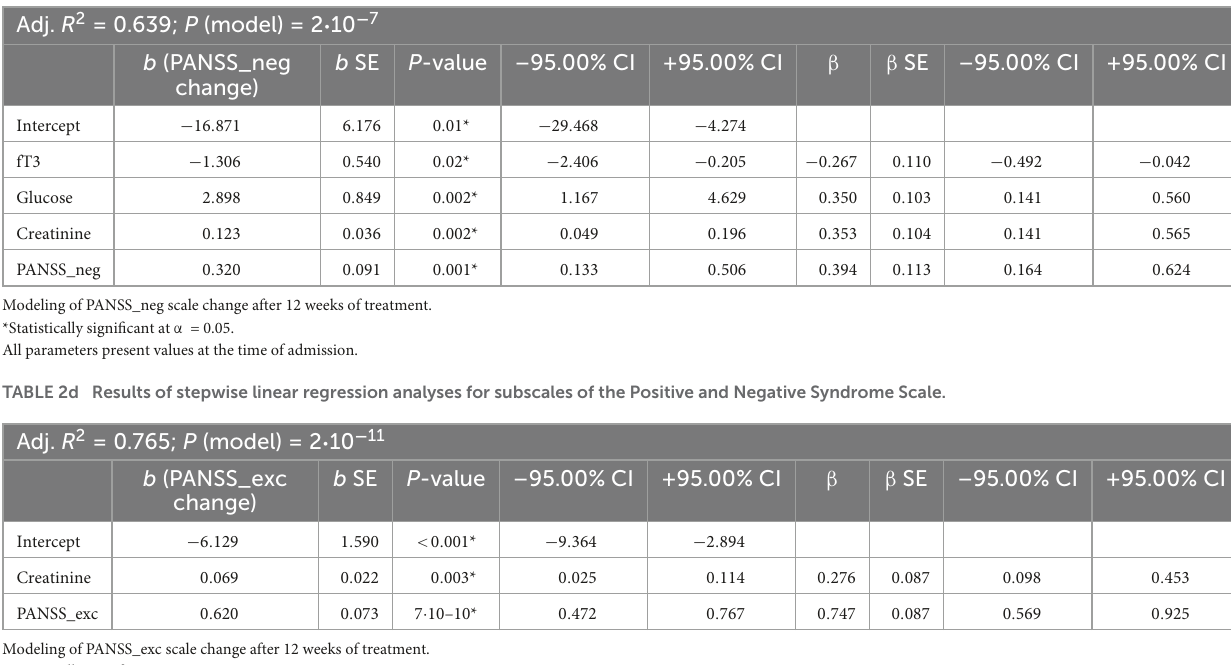
TABLE 2c Results of stepwise linear regression analyses for subscales of the Positive and Negative Syndrome Scale.